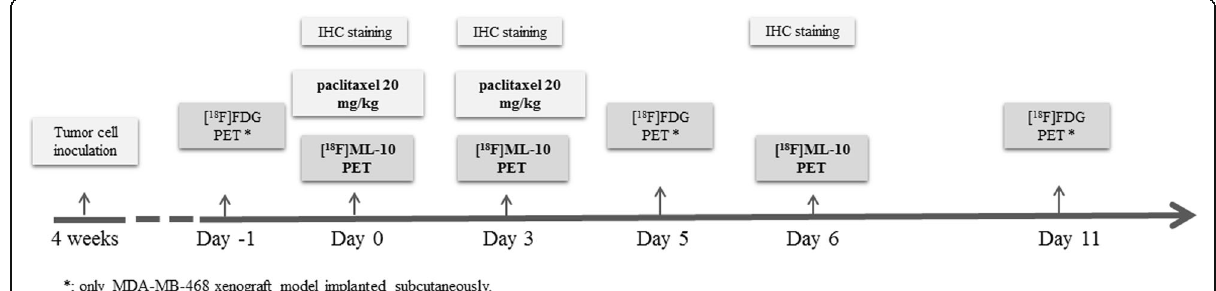
Fig. 1 Study design with small-animal PET imaging of a murine breast tumor model by subcutaneous or orthotopic implantation. IHC indicates immunohistochemical and PET indicates positron emission tomography acquisition